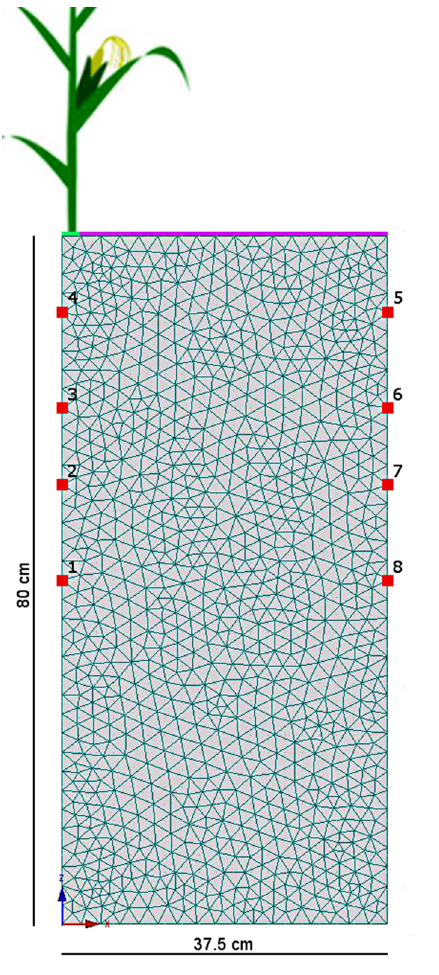
Figure 4. 2D domain geometry, mesh composition and node positions in HYDRUS 2D/3D for the inverse